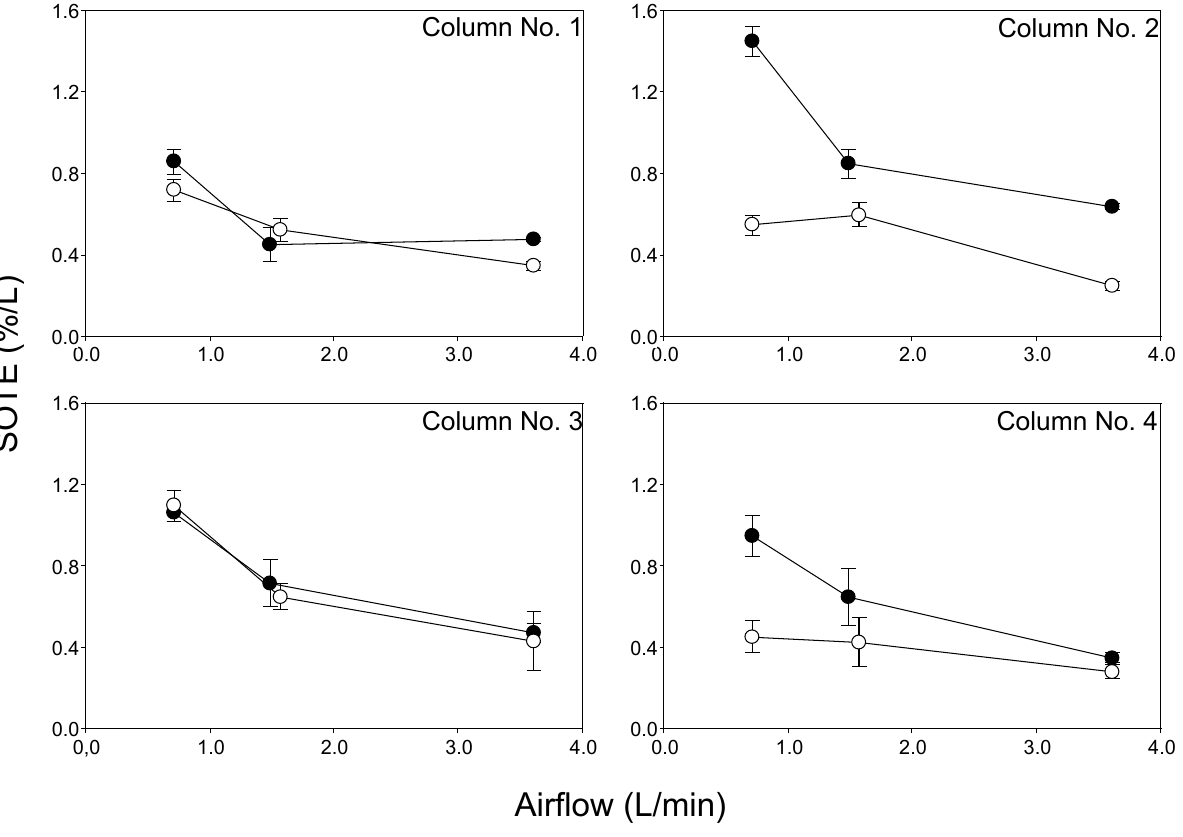
Figure 4. Specific oxygen transfer efficiency (SOTE) by liter in each location: ( ) location 1, Universidad Católica de Maule (Talca, Chile); ( ) location 2, Universidad Militar Nueva Granada (Cajicá, Colombia).